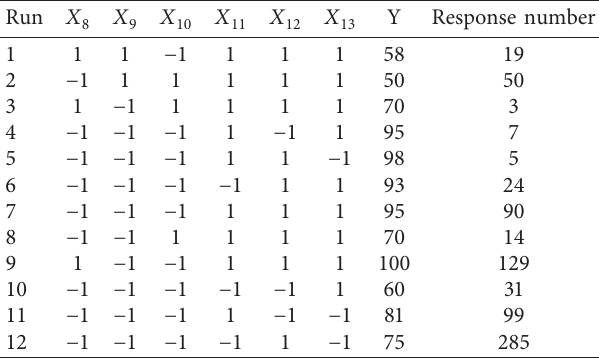
Table 15: One replicate for Example 5.